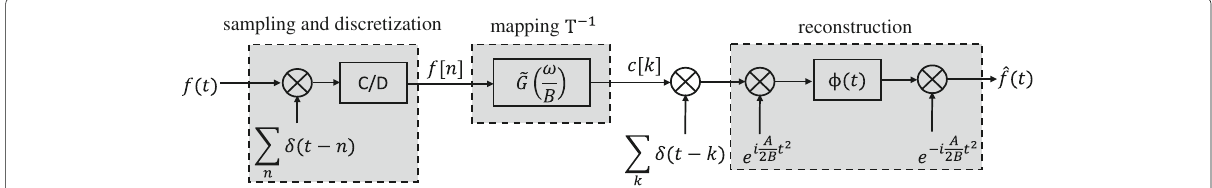
Fig. 7 Block diagram representation of the shift sampling and reconstruction procedure in multi-resolution subspaces associated with the LCWT. a The analog input signal f ( t ) is shift sampled and discretized (the box C/D stands for continuous-to-discrete transformation). b The operator T − 1 maps samples f ( t n ) (or D − u [ f ] ( n ) ) to sequences c k . c f ( t ) can be reconstructed through (59), where c δ ( t ) =